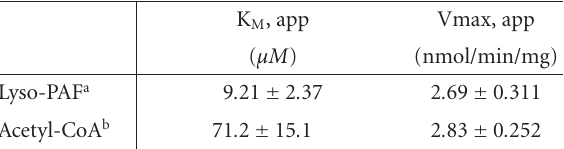
Table 2. Kinetics parameters of lyso-PAF AT of total membrane fractions of mesangial cells ( n = 5).